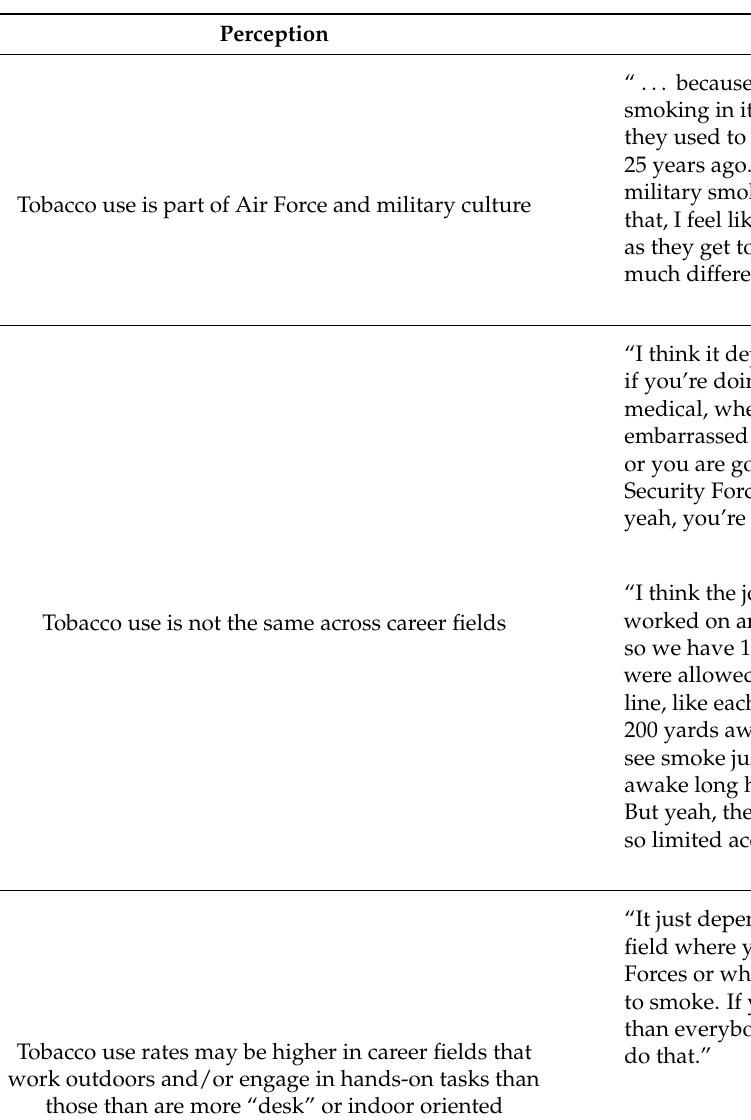
Table 2. Airmen’s Broad Perceptions of Tobacco Use in the Air Force and across Career